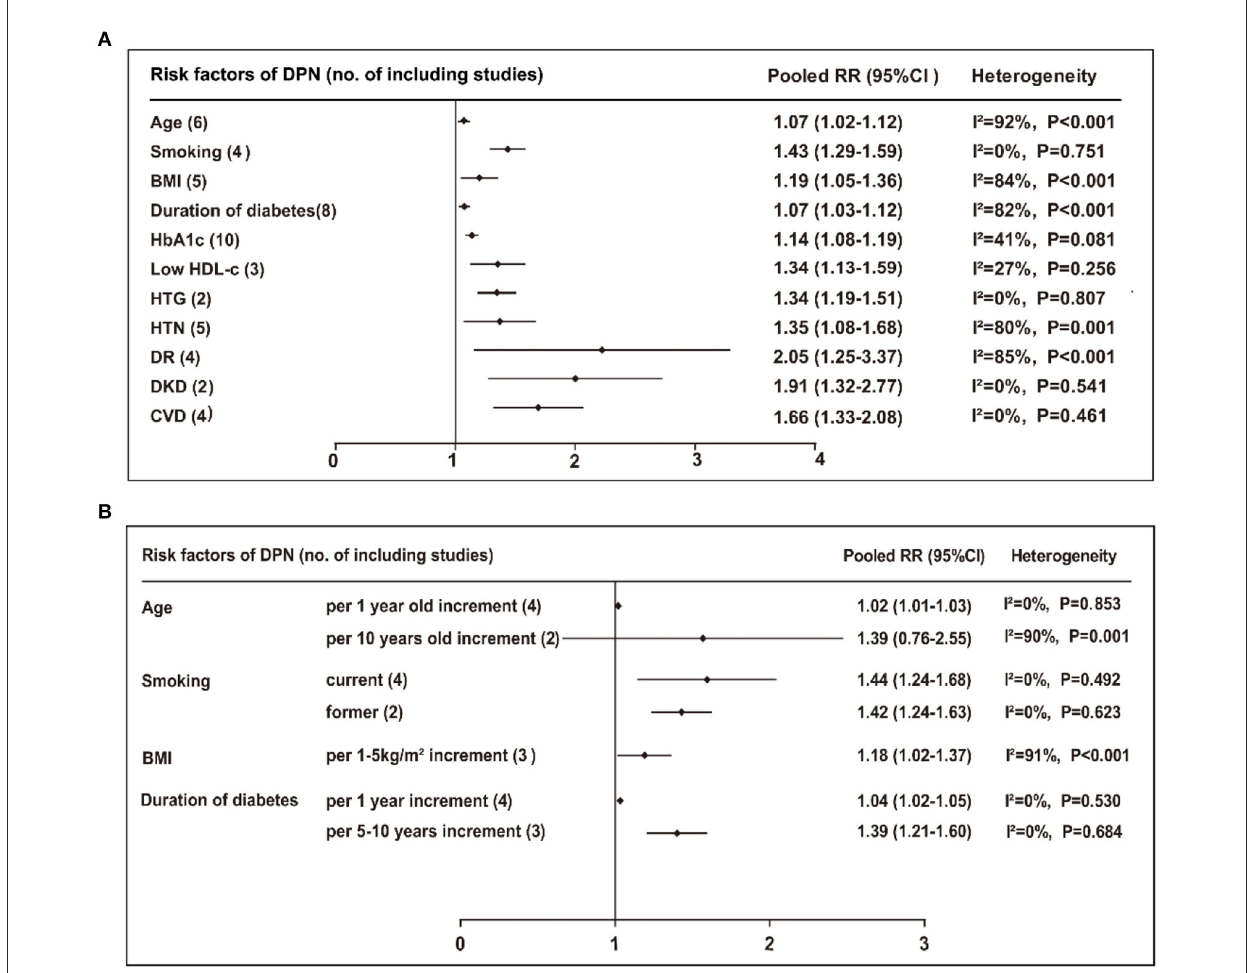
FIGURE3 (A) Pooled RR (95% CI) and heterogeneity test of the risk factors for developing DPN. (B) Subgroup or sensitivity analyses of the risk factors for DPN. BMI, body mass index; HbA1c, Hemoglobin A1c; HDL-c, high density lipoprotein cholesterol; HTG, high triglyceride; HTN hypertension; DR, diabetic retinopathy; DKD, diabetic kidney disease; CVD, cardiovascular disease.